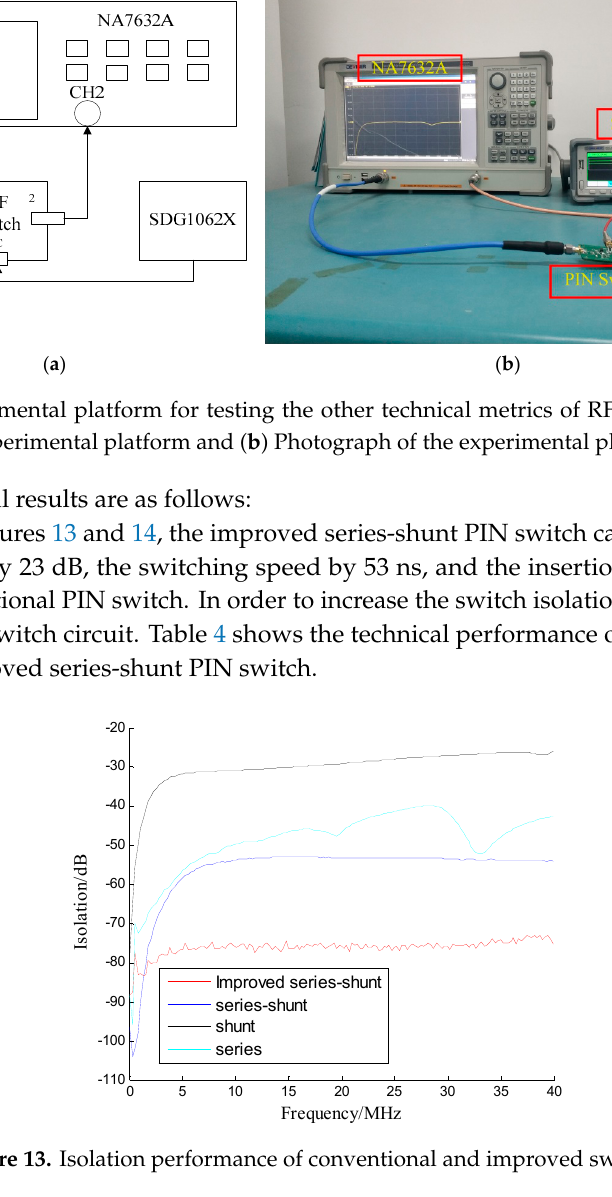
Figure 14. Insertion loss performance of conventional and improved switches.